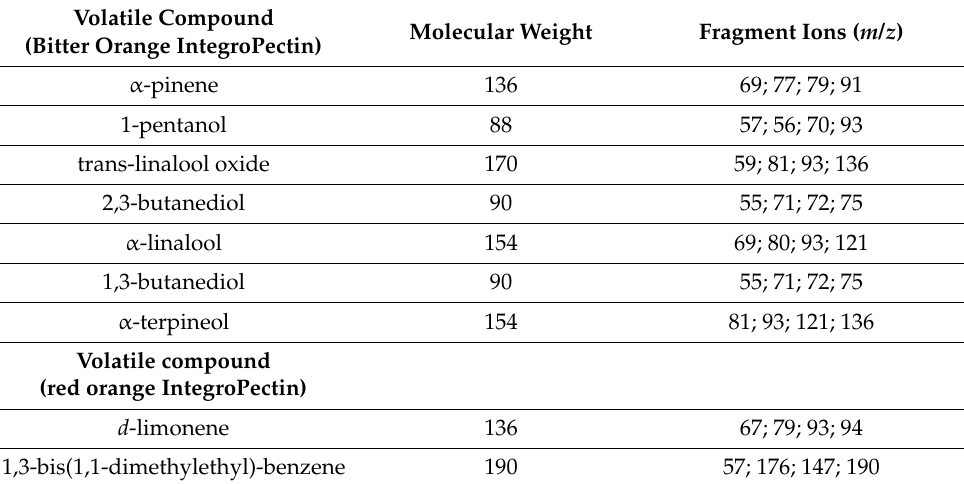
Table 4. Mass of the volatile analytes and fragment ions in both orange IntegroPectin